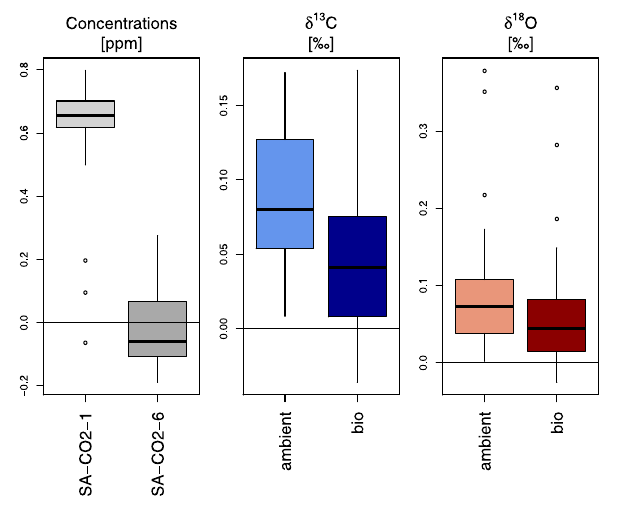
Figure 6. Box-and-whisker plots for the deviations of calibrated concentrations and δ values from laboratory measurements (at MPI in Jena) for repeated measurements of different calibration tanks (see Table 3 for c and δ values of the gas tanks) over a period of 9 days ( N = 36). Delta values were measured at 400ppm and “ref- erencing” was done approximately every 30min at 380ppm to sim- ulate conditions during a measurement campaign. Table 6. Uncertainties related to the different calibration steps and their repeatability, defined as 1 σ standard deviation of the respective calibration step.